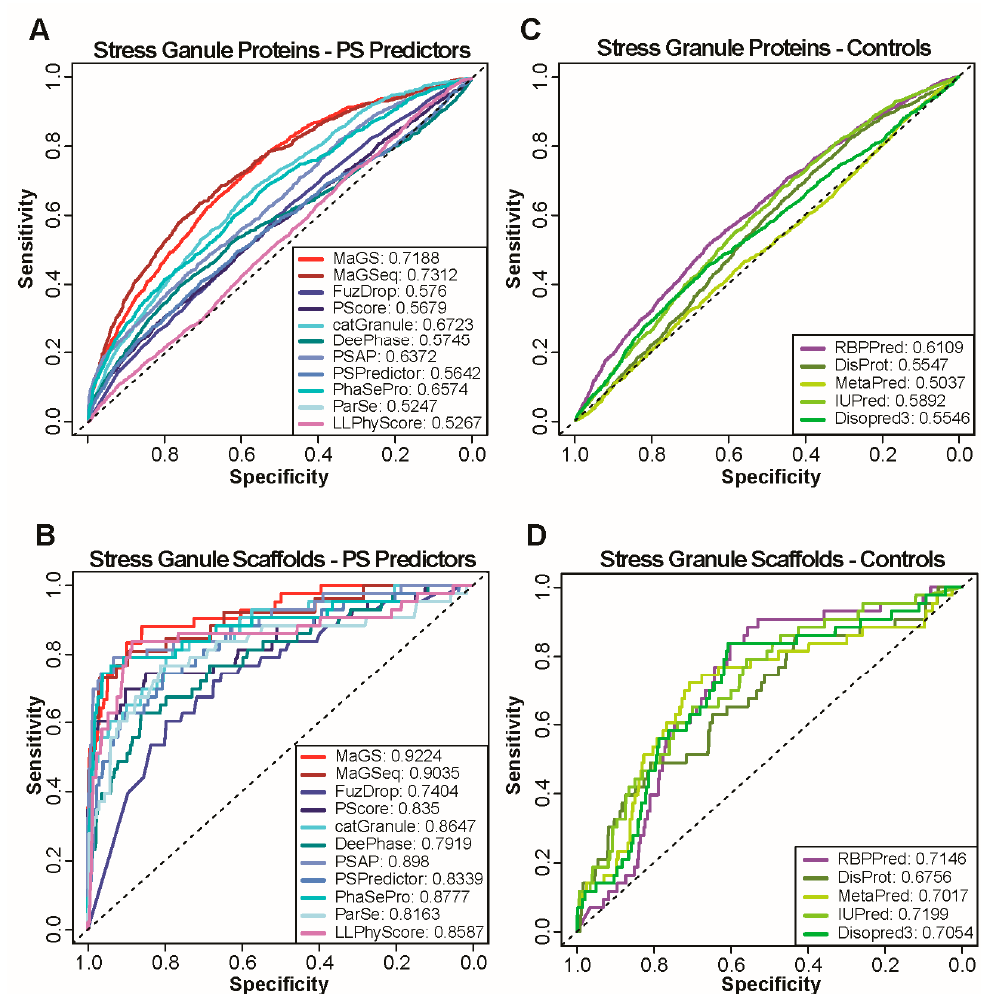
Figure 1. Performance of state-of-the art methods and simple protein features on stress granule localization prediction. ( A , C ) ROC curves calculated with predictions by catGranule, DeepPhase, FuzDrop, MaGS, MaGSeq, ParSe, PSAP, PScore, PSPred and LLPhyScore ( A ) as well as simple protein features obtained by using the sources listed ( C ). Curves are calculated using all stress granule proteins as positives and NS1 as negative set. AUC values are provided for each method in the legend. ( B , D ) ROC curves calculated with predictions of same methods and features as in A and C. Curves are calculated using only scaffolds of stress granule formation as positives and NS1 as negative set.